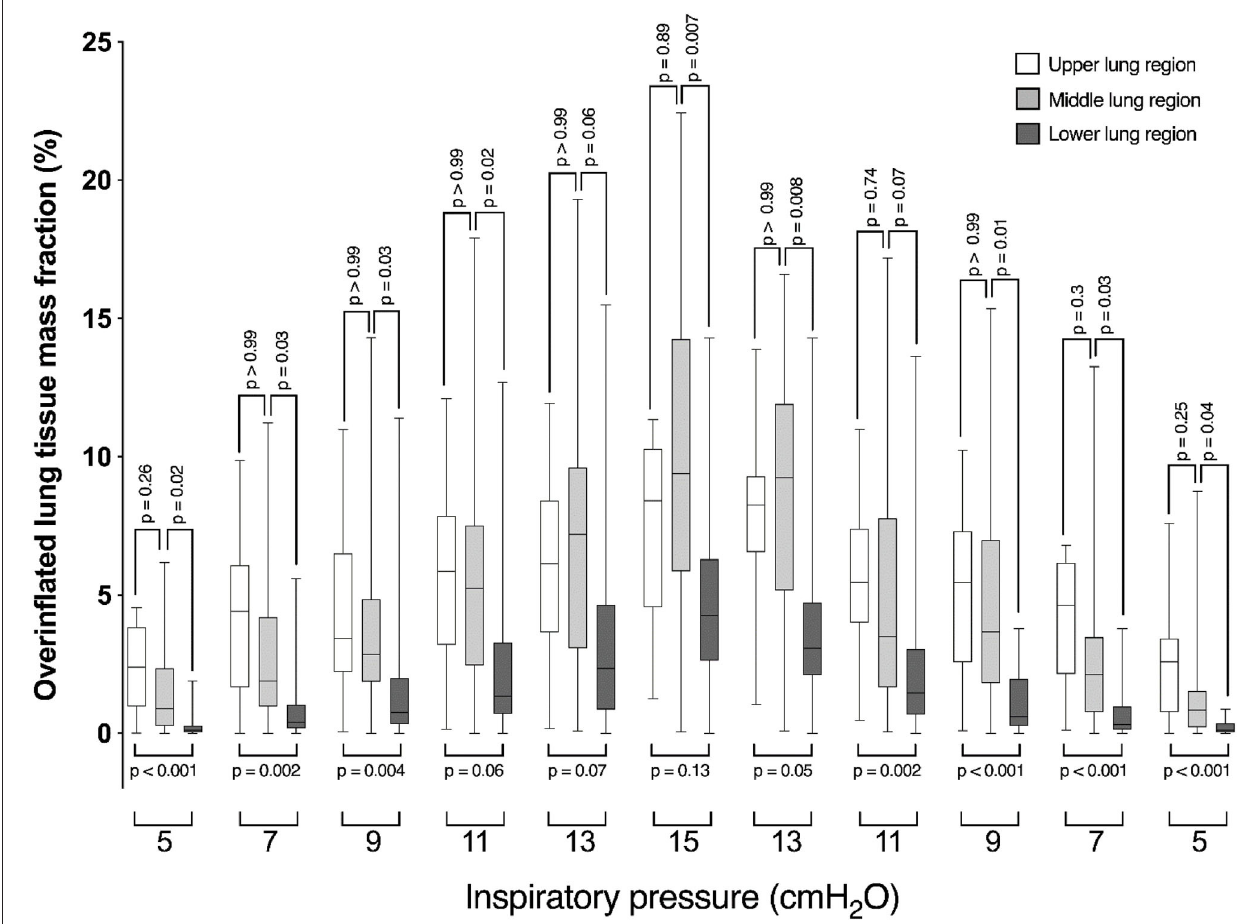
FIGURE 2 | Box-plot graph showing the fraction of over-inflated lung tissue mass of ventral (open box-plots), middle (light gray box-plots), and dorsal (dark gray box-plots) lung segments in diverse airway pressure